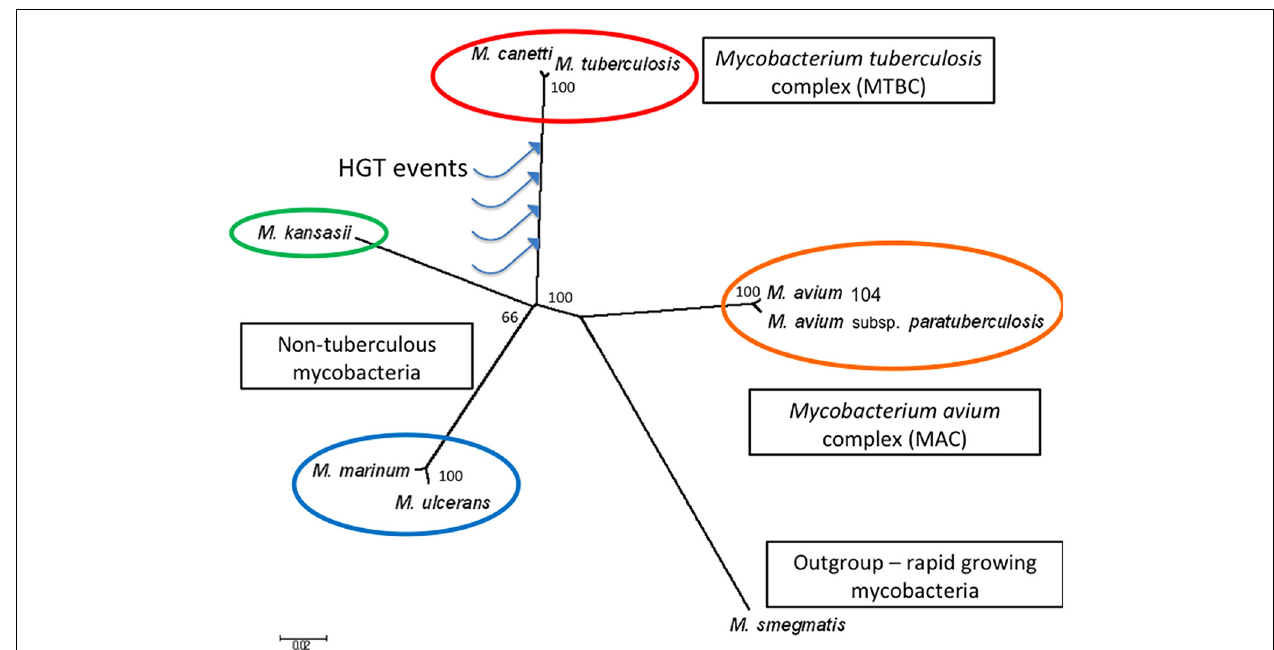
replicates) are shown at the branch points.The fast growing species M. smegmatis is used as the out-group. Genes used are listed below (represented as M. tuberculosis genes): Rv0001 - dnaA , Rv0041 - leuS , Rv0236A – Rv0236A , Rv0248c – Rv0248c , Rv0285 - PE5 , Rv0287 - esxG , Rv0288 - esxH , Rv1085c – Rv1085c , Rv0197 – Rv0197 , Rv1304 - atpB , Rv1305 - atpE , Rv1894c – Rv1894c , Rv2172c – Rv2172c , Rv2392 - cysH , Rv2440c - obg , Rv2477c – Rv2477c , Rv3019c - esxR , Rv3045 - adhC , Rv3392c - cmaA1 , Rv3502c - hsd4A .